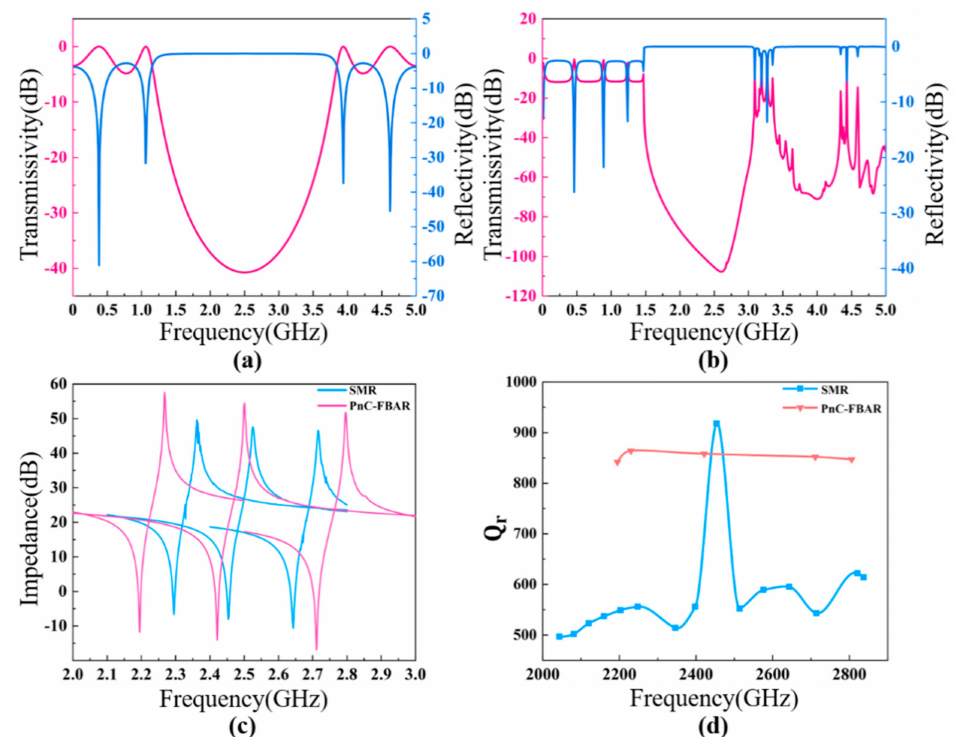
Figure 12. Transmissivity and reflectivity of the Bragg structure ( a ). Transmissivity and reflectivity of the square lattice PhC ( b ). Comparison of impedance curves at different working frequencies for SMRs and PhC-FBARs with the same acoustic isolation structure ( c ). Comparison of Q values at different working frequencies for SMRs and PhC-FBARs ( d